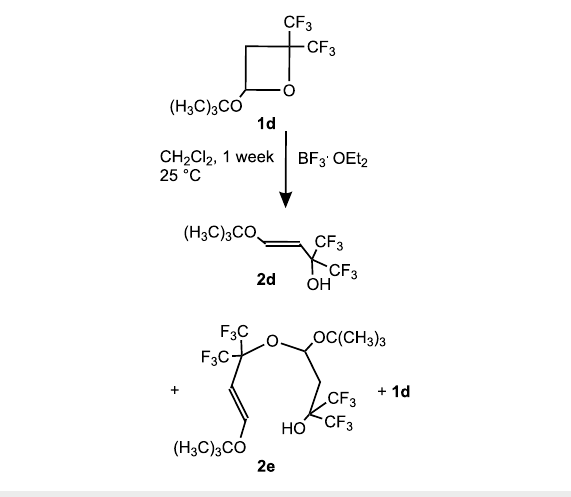
Scheme 2: Reaction of 1d with BF 3 ·OEt 2